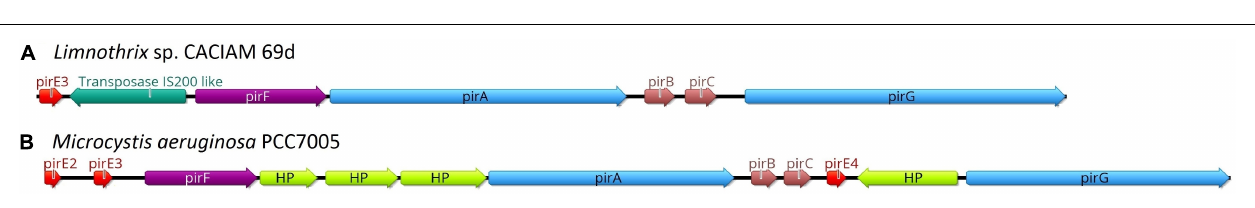
FIGURE 8 | Piricyclamide gene cluster schematics. (A) Cluster found in Limnothrix sp. CACIAM 69d contig MKGP02000097 and (B) cluster previously described in Microcystis aeruginosa PCC7005. The precursor genes are shown in red, proteases are blue, prenyltransferase is purple, genes with no prediction function are brown, hypothetical proteins (HP) are light green, a transposase is dark green, and R is for repeat region.